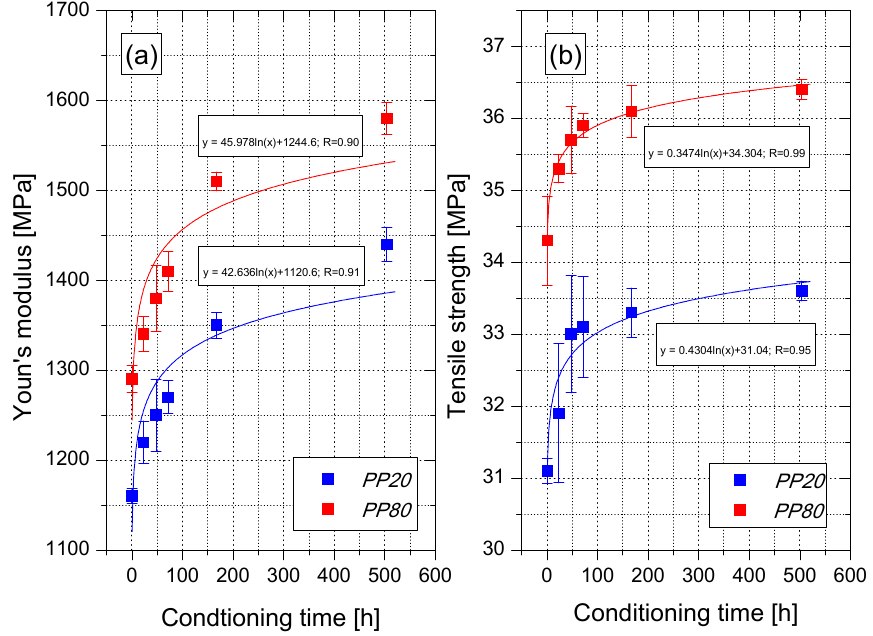
Figure 6. Changes of the E modulus ( a ) and tensile strength ( b ) of PP samples in the function of conditioning time. Similar trends were observed in the case of changes in the tensile strength values (6b). After 1 h of conditioning, R m of PP80 samples was equal to 34.3 MPa, being 10% higher in comparison with PP20 samples. The most significant changes in the tensile strength values were observed up to 48 h of conditioning. After 168 h of conditioning, the increase in R m value in comparison with the tensile strength after 1 h of conditioning was 7% (33.3 MPa) for PP20 and 5% (36.1 MPa) for PP80, respectively. These relative changes in values were